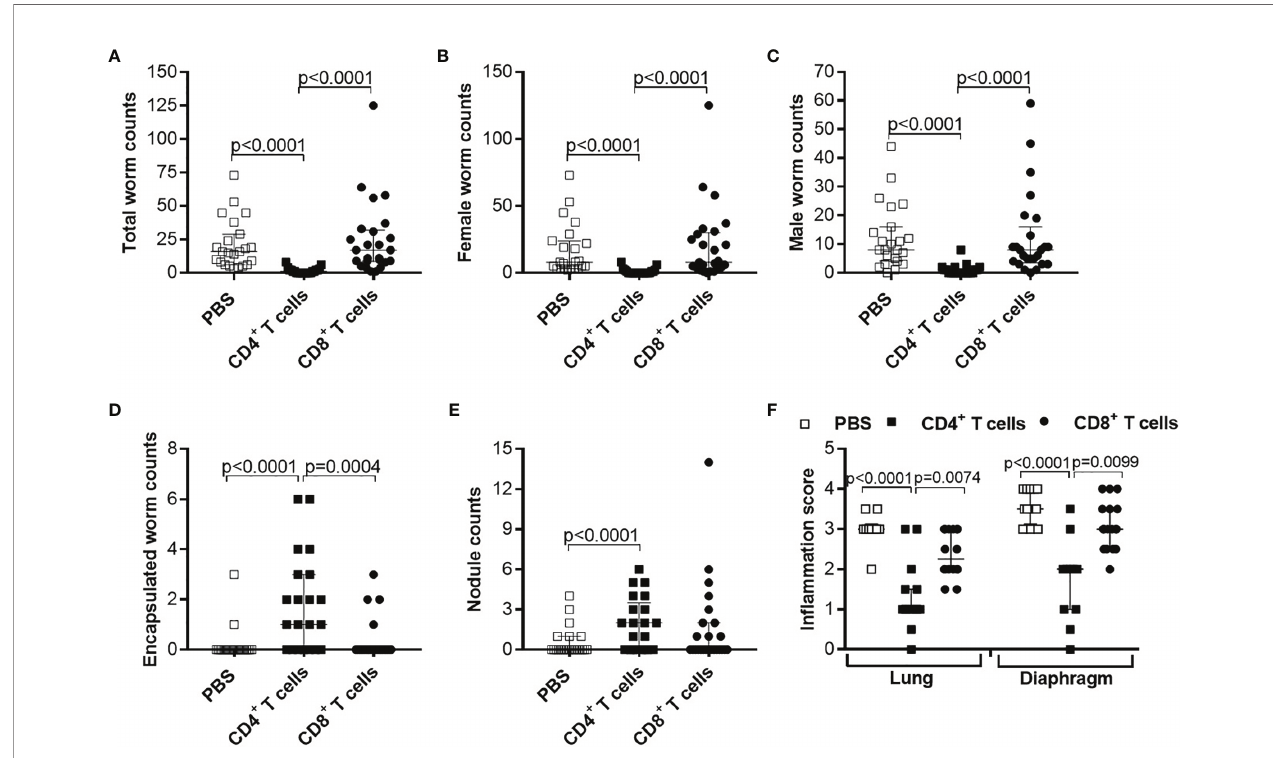
FIGURE 4 | Reduced worm counts and thoracic cavity pathology in L. sigmodontis -infected RAG2IL-2R g -/- mice upon adoptive transfer of CD4 + T cell from L. sigmodontis -infected C57BL/6 donor mice. CD4 + or CD8 + T cells from C57BL/6 donor mice that were infected with L. sigmodontis for 28 days were injected intravenously (i.v.) into the tail vein of RAG2IL-2R g -de fi cient C57BL/6 mice one day prior to L. sigmodontis infection. On day 72 p.i. mice were analysed to assess (A) total, (B) female, (C) male and (D) encapsulated worm counts as well as (E) nodule counts in the thoracic cavity. In addition, H&E-stained lung and diaphragm sections were microscopically analysed to assess the (F) in fl ammation score. Graphs show dot blots with median and interquartile ranges from individual mice from (A – E) three independent experiments including no adoptive transfer (PBS; n=23) and adoptive transfer of CD4 + (n=21) and CD8 + T cells (n=25) and (F) two independent experiments including PBS (n=10) and adoptive transfer of CD4 + (n=15) and CD8 + T cells (n=16) into RAG2IL-2R g -de fi cient C57BL/6 mice. Signi fi cant differences between the groups were determined by Kruskal-Wallis-test followed by a Dunn ’ s multiple comparison